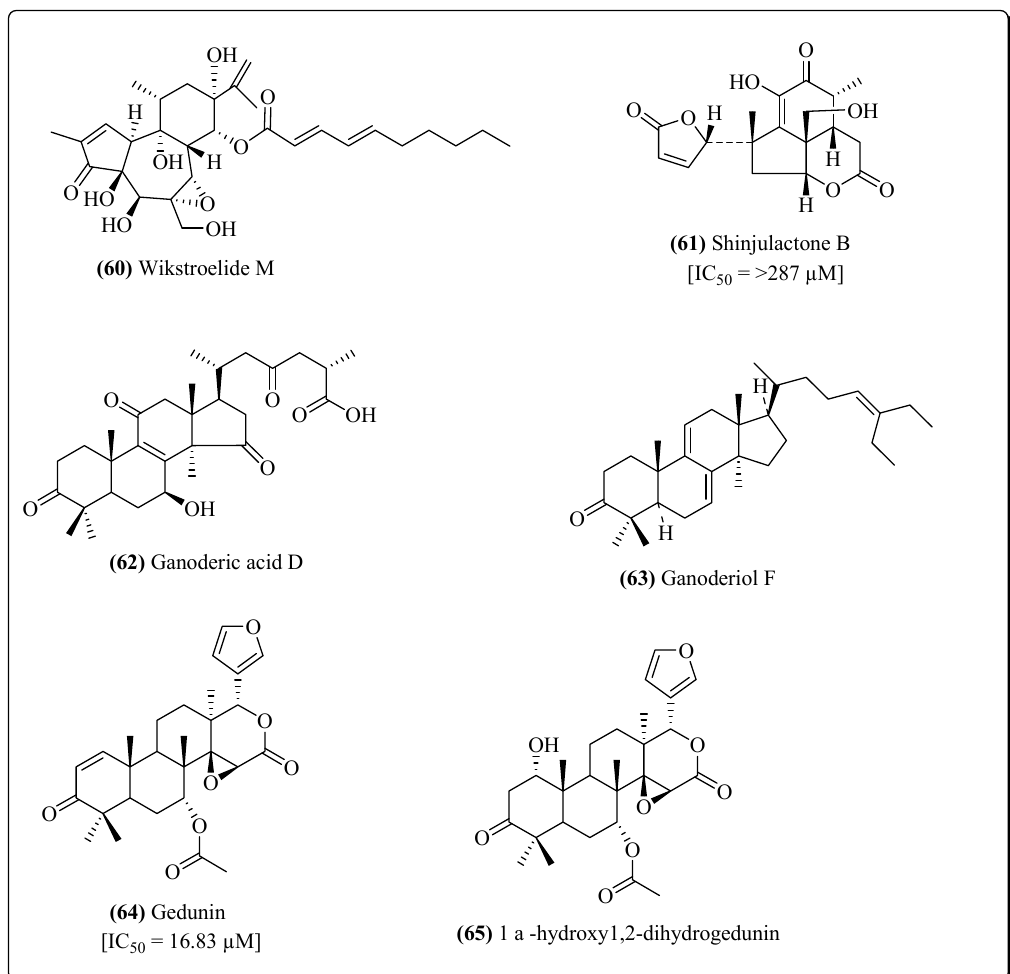
Figure 13. More potent terpenoids against HIV.